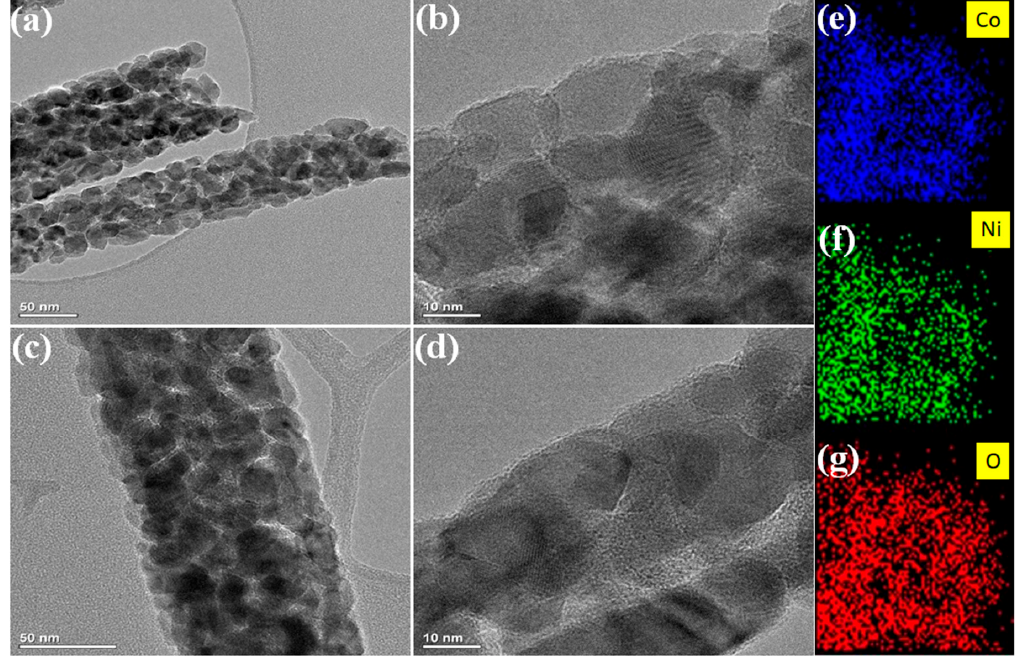
Figure 2. TEM and HR-TEM images of the NF@NCO/NCO NFAs ( a ) and ( b ) and NF@NCO NLAs ( c ) and ( d ) grown on nickel foam at different magnifications and STEM-EDS color elemental mapping images of the NF@NCO/NCO NFAs electrode ( e – g ).